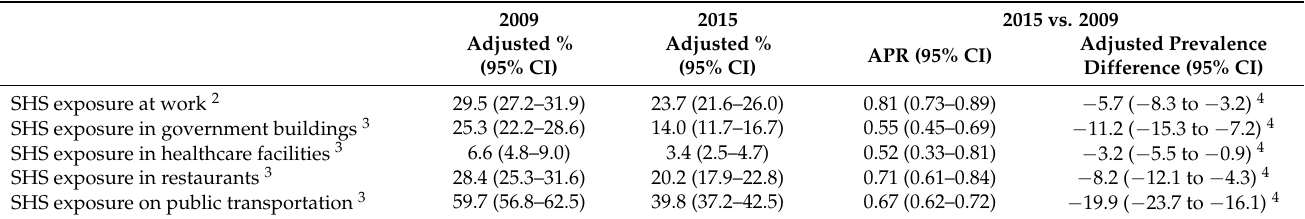
Table 4. Adjusted prevalence 1 of SHS exposure by sociodemographic characteristics, tobacco use, and smoking policies among adults aged 15 years or older in the Philippines, 2009 and